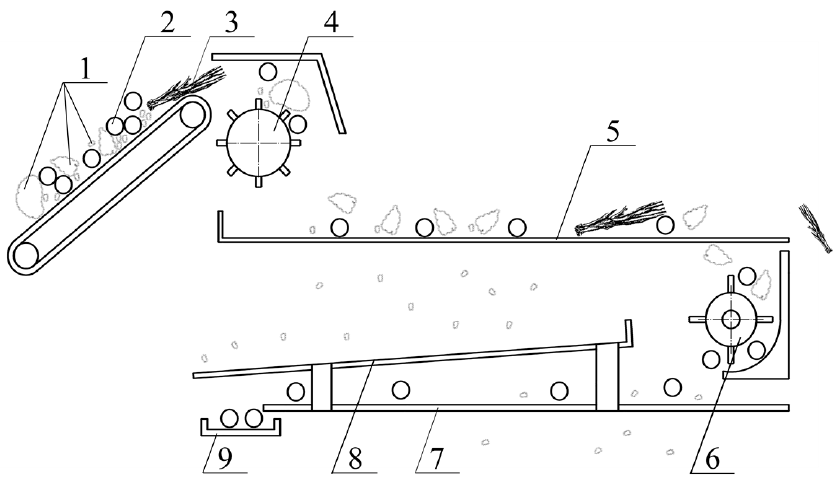
Figure 3. Schematic of the working principle. 1. Soil particles; 2. Tiger nut particles; 3. Stalk; 4. Threshing drum; 5. Upper sieve; 6. Guide drum; 7. Lower sieve; 8. retaining plate; 9. Horizontal sieve.